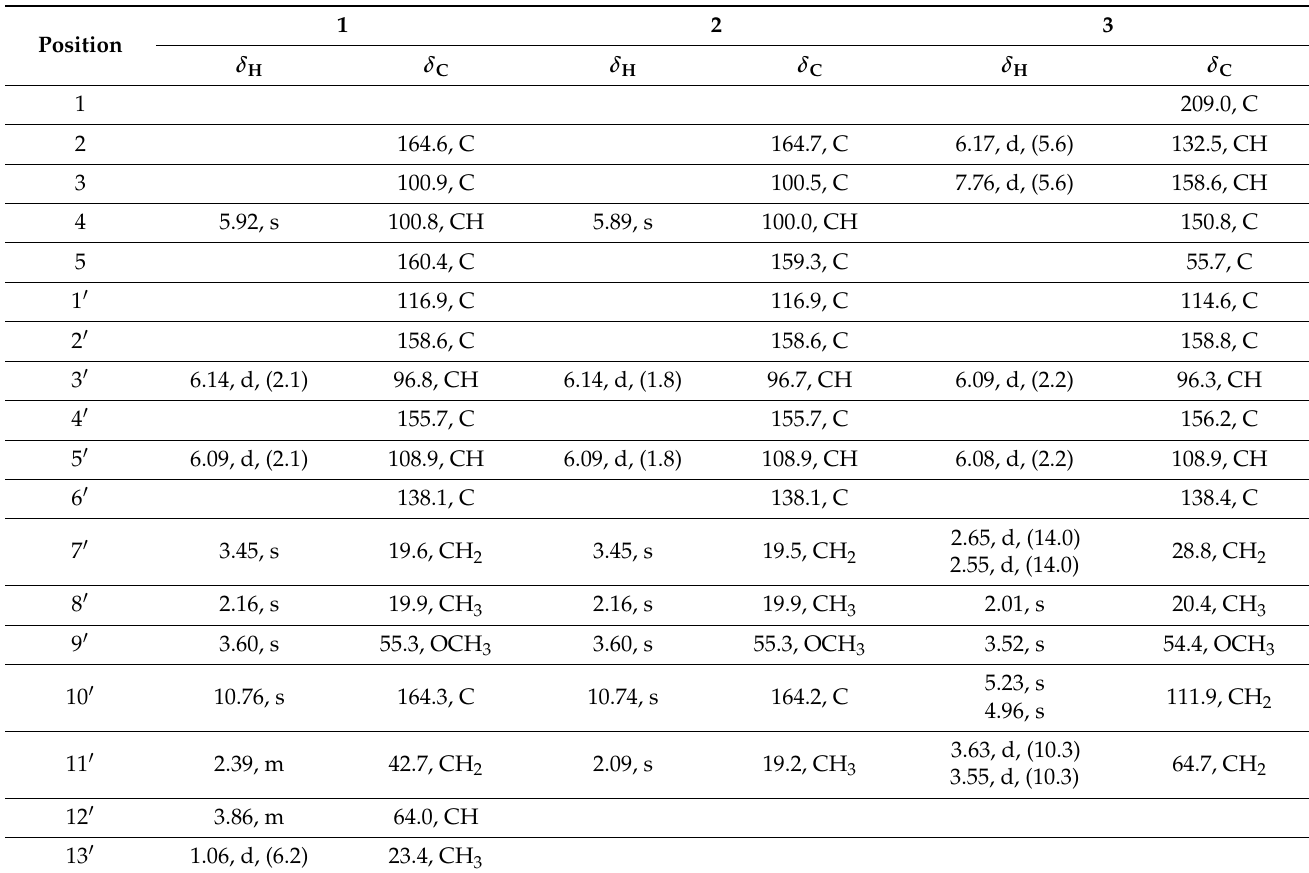
Table 1. 1 H and 13 C NMR data of 1 – 3 in DMSO- d 6 ( δ in ppm, J in